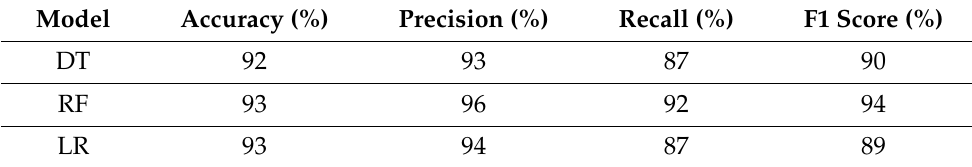
Table 14. Performance results for machine learning models using TextBlob sentiments.